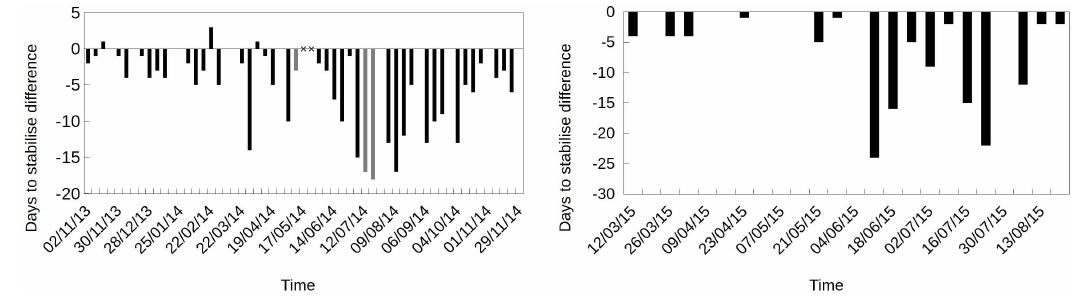
Figure 9. Difference between the length of the hypothetical monitoring campaign required by the 2TM model and the average method to stabilise for the SWall ( left ) and the CWall_N ( right ). The crosses mark a period of missing data, while the grey bars indicate the periods where only the 2TM model